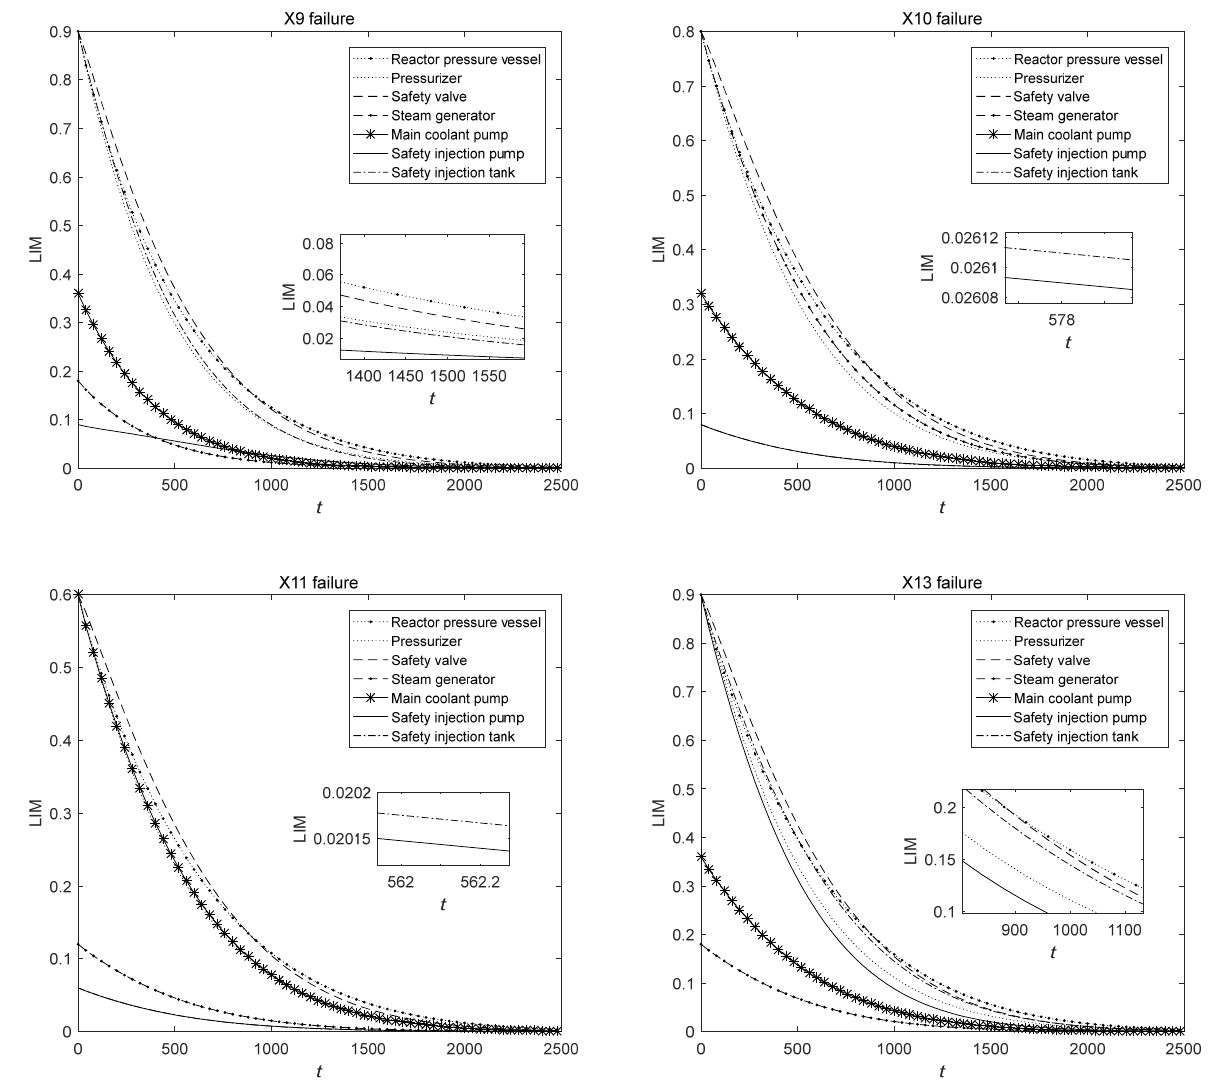
Figure 2. Component maintenance priority in the case of a single component failure.